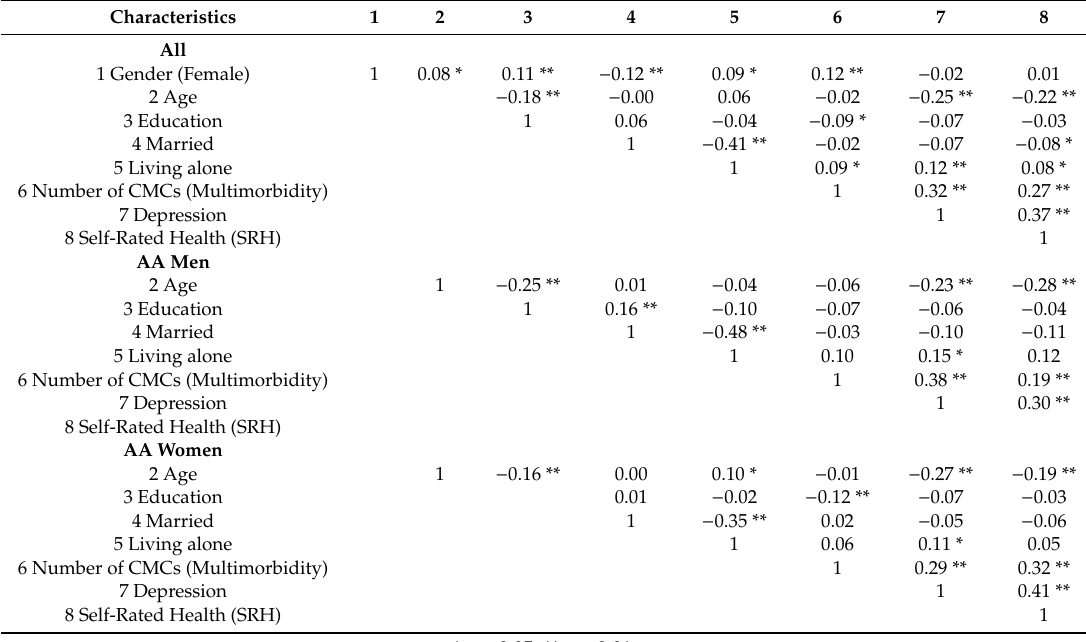
Table 2. Bivariate correlation matrix of the sample, both pooled and by gender.